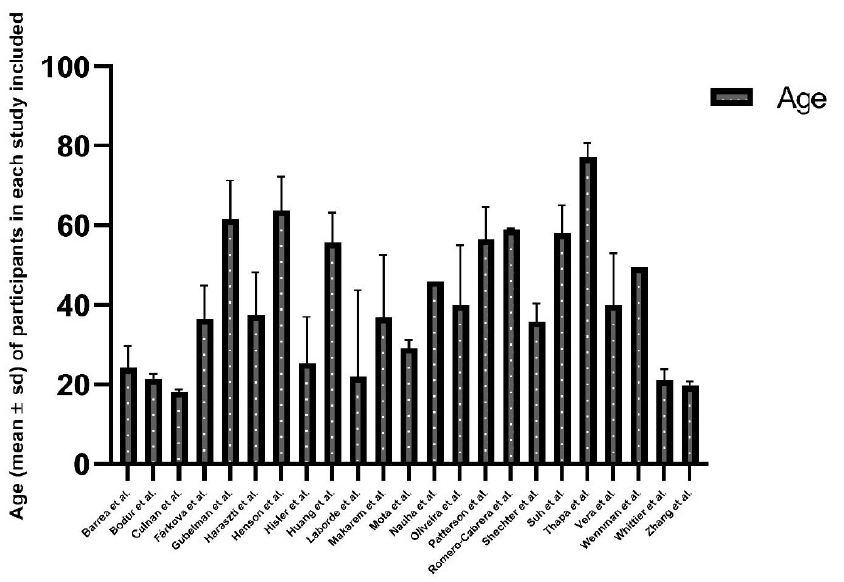
Figure 2. Age (mean) of participants in each included study [26–48].